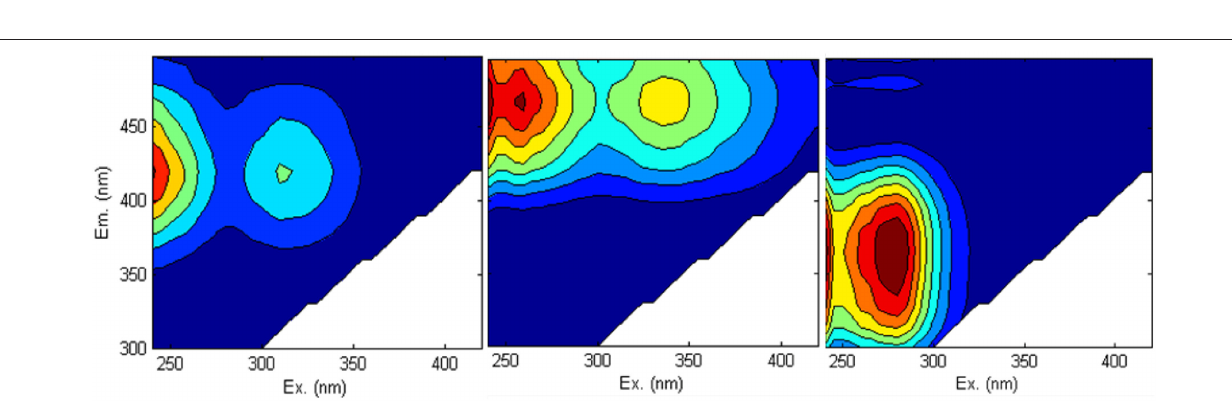
Frontiers in Marine Science |